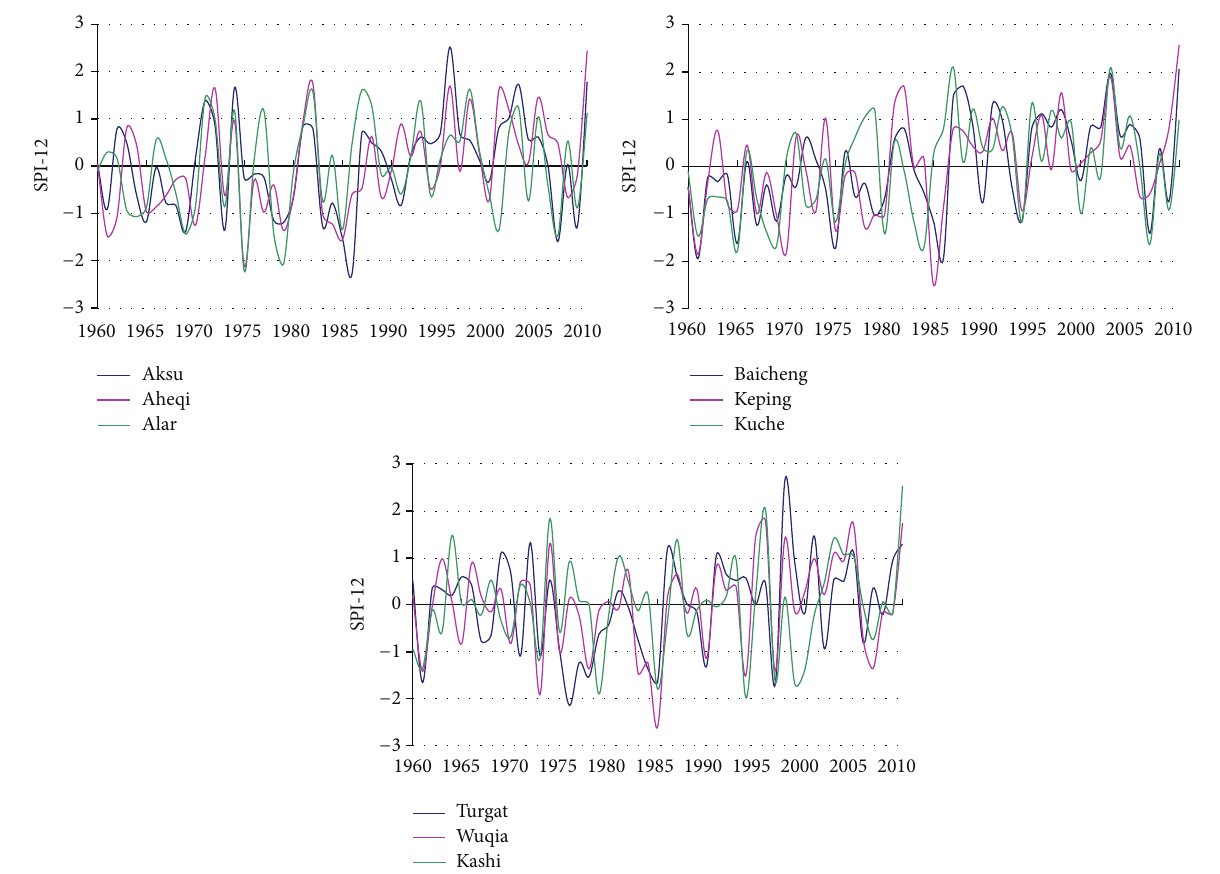
Figure 7: Time series of SPI-12 at the 9 synoptic stations.